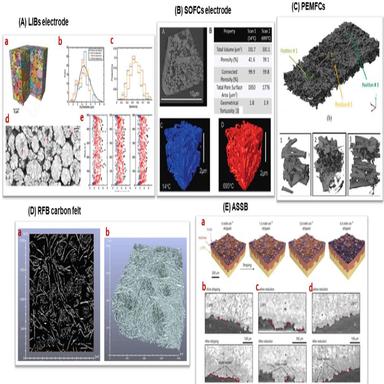
.2. (a) Morphology of the NMC phase in electrode (a) 3D volume with individual particles labelled; (b) Particle size distribution in the volume; (c) distribution of sphericity of NMC; (d) cross-section of the sample; (e) Spatial repartition of the NMC particles in the three samples in the direction normal to the current collector ; (b) (a) Individual tomogram from the high temperature tomography sequence; (b) Material properties for full tomography data; (c) 3D rendering of selected region of interest from